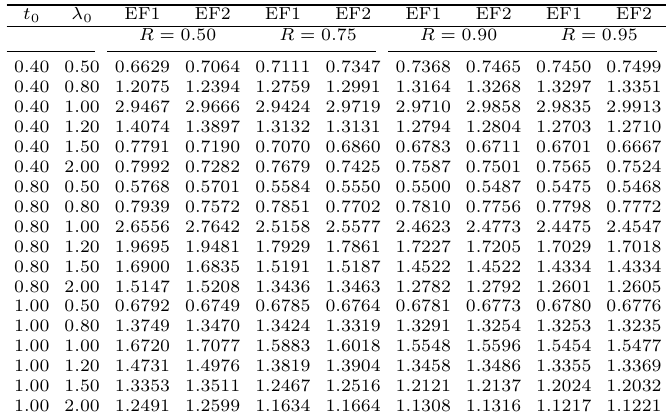
Relative efficiencies of the estimators for R ( t ) under Type I censoring